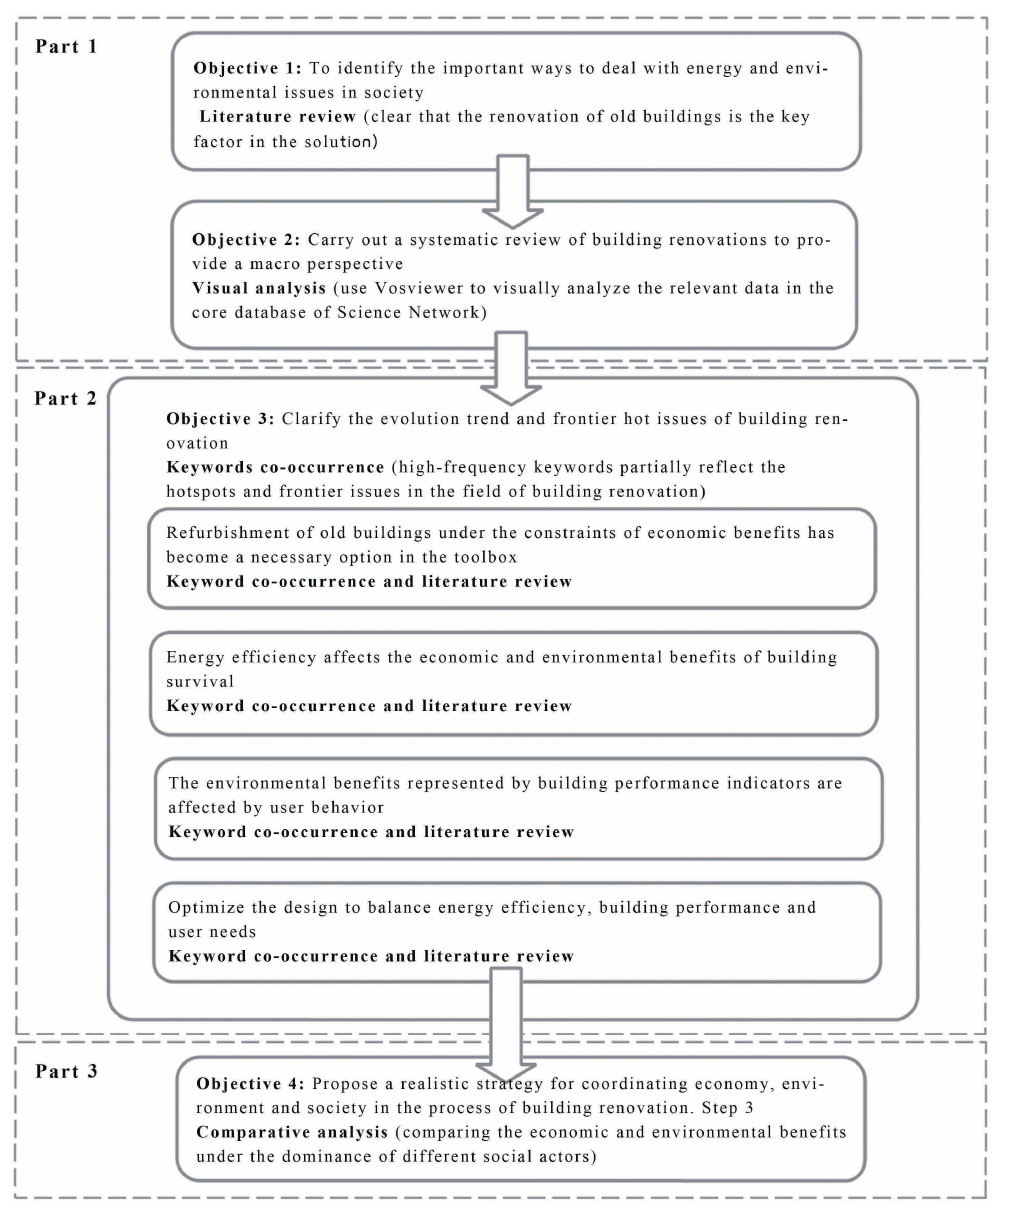
Figure 1. Research